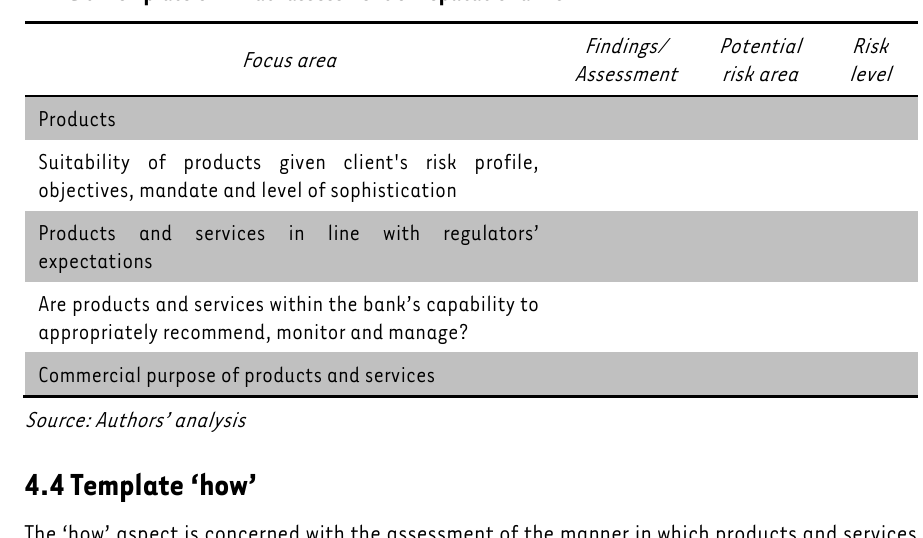
TABLE 3: Template of ‘what’ assessment of reputational